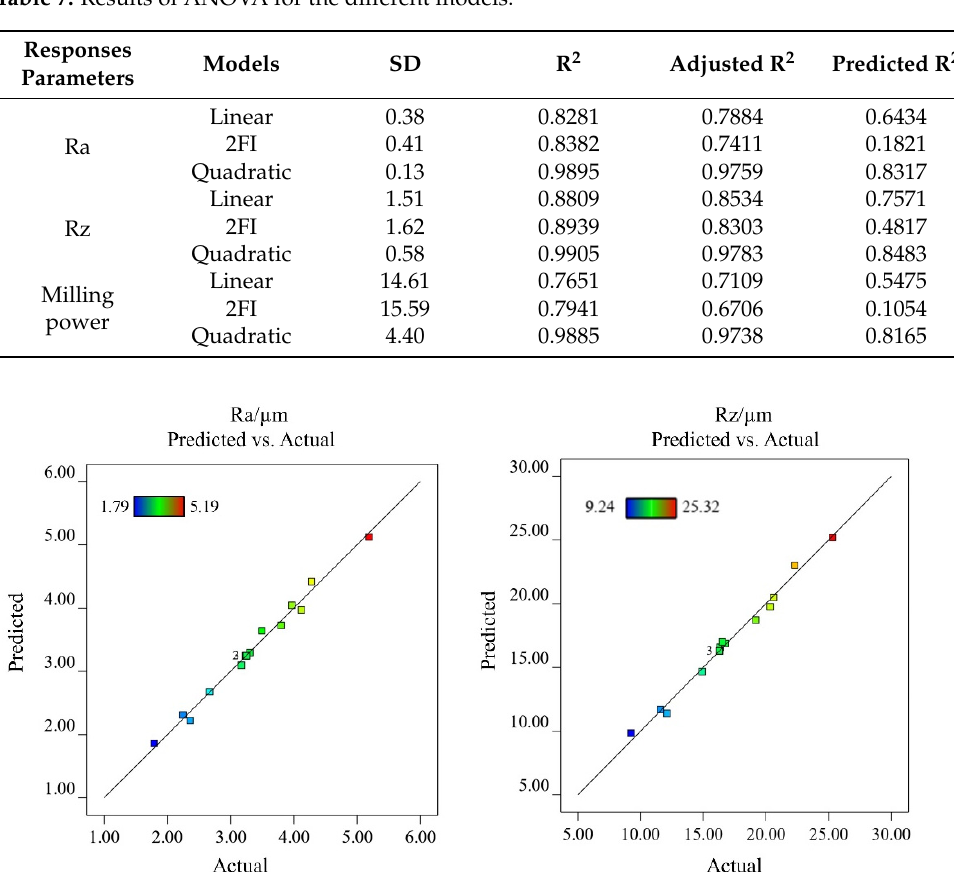
Figure 6. The plot of predicted vs. actual values for Ra, Rz, and milling power. Table 7. Results of ANOVA for the different models. Responses Parameters